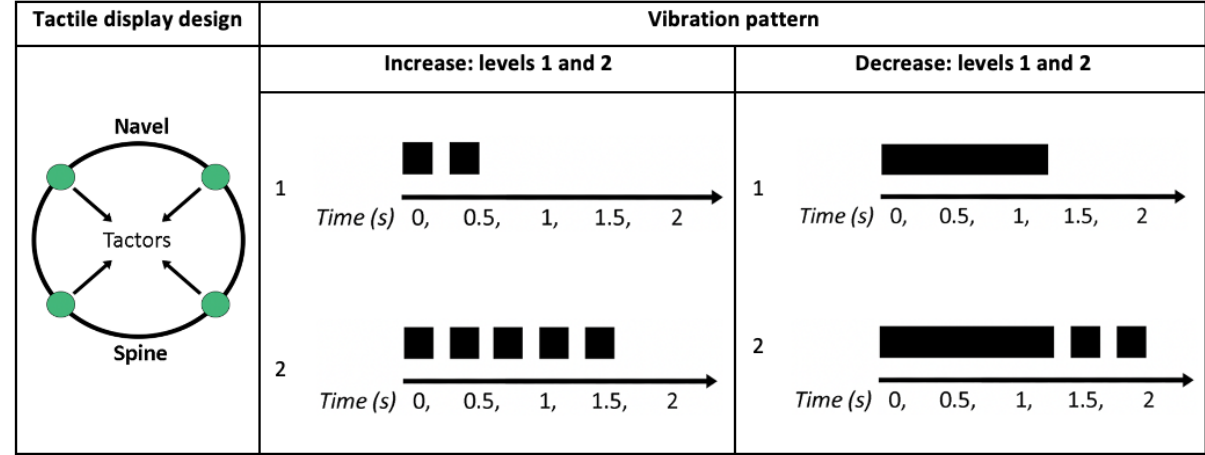
Figure 8. Tactile display worn around the waist. Each tactor represented a variable with 4 possible vibration patterns (permission to use the image obtained through